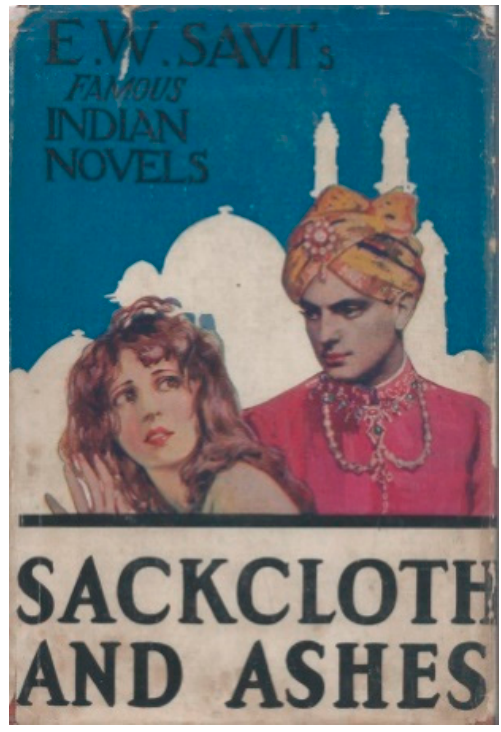
Figure 6. Sackcloth and Ashes by E.W. Savi 1925.